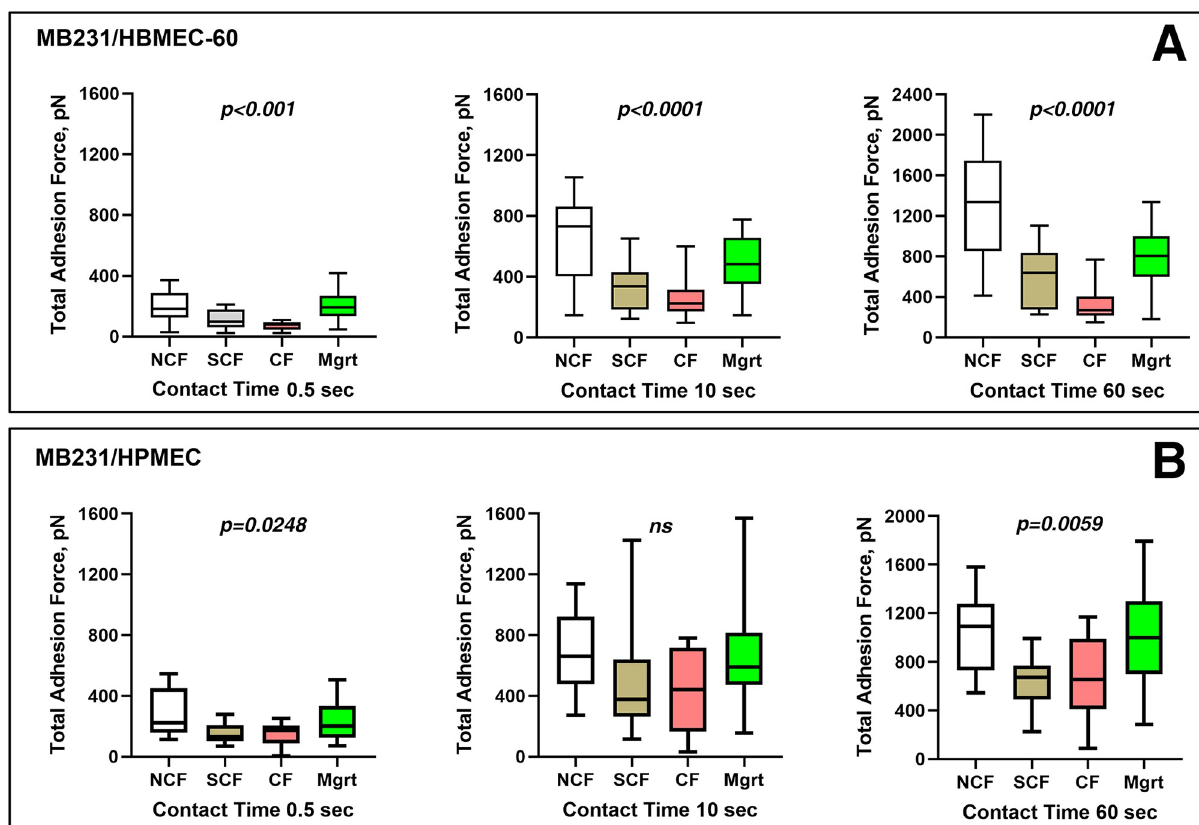
Fig 7. Total MB231/HBMEC-60 and MB231/HPMEC adhesion forces in different EC growing states for three cell-cell contact times. Box diagrams showing changes in total adhesion forces between MB231 human breast carcinoma cells and HBMEC-60 (top panel A) and HPMEC (bottom panel B) endothelial cells at four different growth/confluency states, NCF (non-confluent), SCF (sub-confluent), CF (confluent) and Mgrt (migrating) and three (0.5 sec, 10 sec, 60 sec) cell-cell contact times. Whiskers, 5%– 95%. P –Ordinary One-Way ANOVA (ns–not significant).